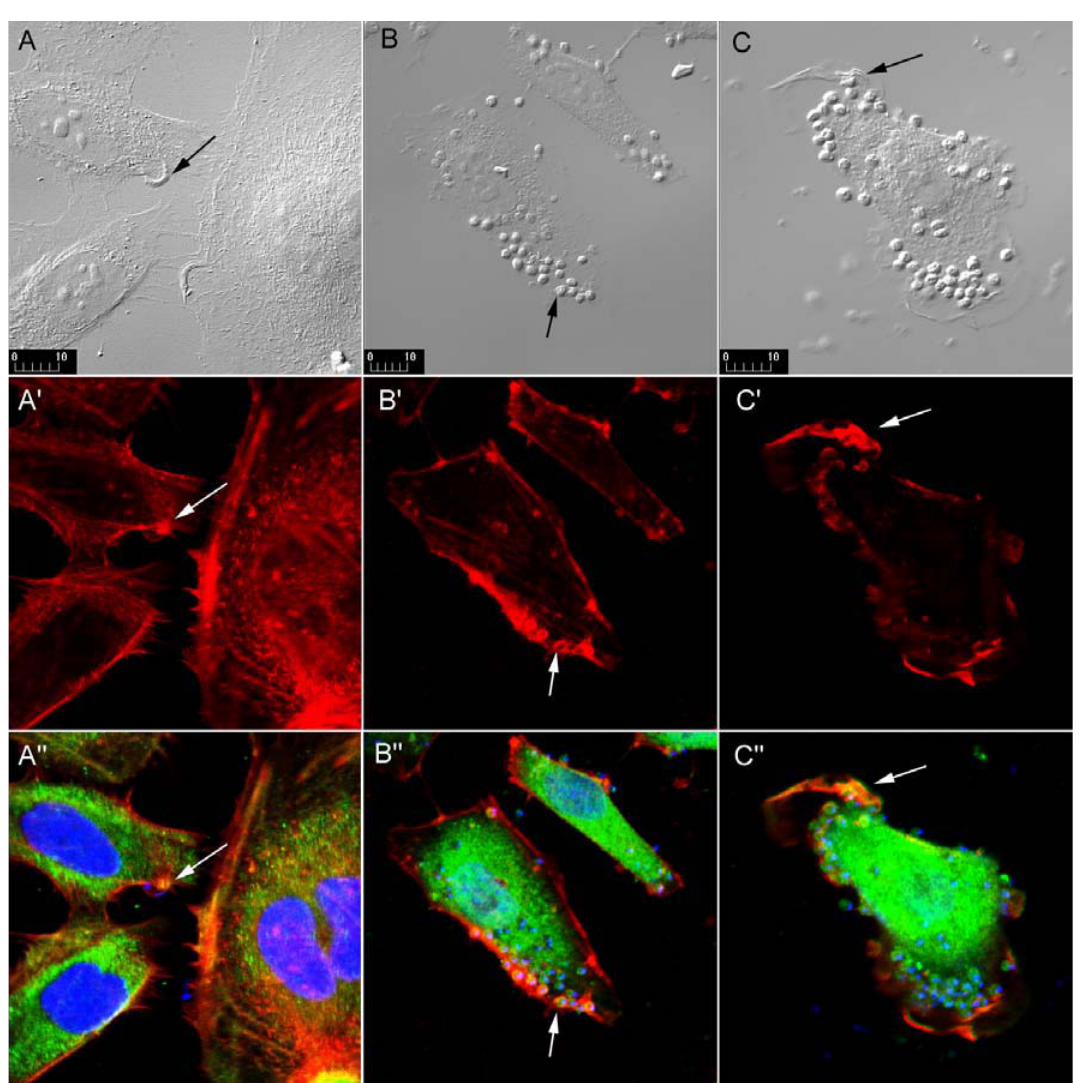
Fig. 4 – Formation of actin-rich membrane extensions around invading T. cruzi infective forms (arrows). A: formation of sleeve-like pseudopodia around trypomastigotes invading HeLa cells, Nomarski DIC image; A’: f-actin labeling with phalloidin-Rhodamine; A”: merged image of actin (red), cytoplasmic f-actin binding proteinABP280 (green), and DNA labeling with DAPI (blue). B: formation of cup-like projections around amastigotes invading HeLa cells, DIC image; B’: f-actin labeling with phalloidin-Rhodamine; B”: merged image with actin (red), cytoplasmic f-actin binding protein gelsolin (green), and DNA labeling with DAPI (blue). C: Crater-like projections around amastigotes invading Vero cells, DIC image; C’: f-actin labeling with phalloidin-Rhodamine; C”: merged image of actin (red), cytoplasmic f-actin binding protein tropomyosin (green), and DNA labeling with DAPI (blue) (Procópio et al. 1999). Magnification bars in µ